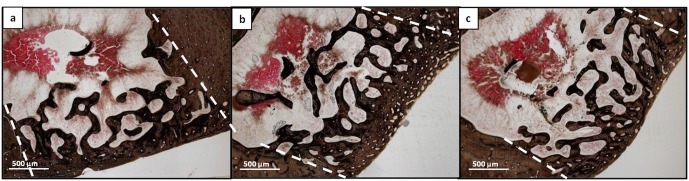
Histological microphotographs of femoral sections at the lesion site 30 days after implantation.
a) Unfilled defect; b) Pluronic F127 filled defects; c) DBM-PF127 composite filled defects. Sections were stained with Von Kossa stain. Dashed line indicate the defect edges.